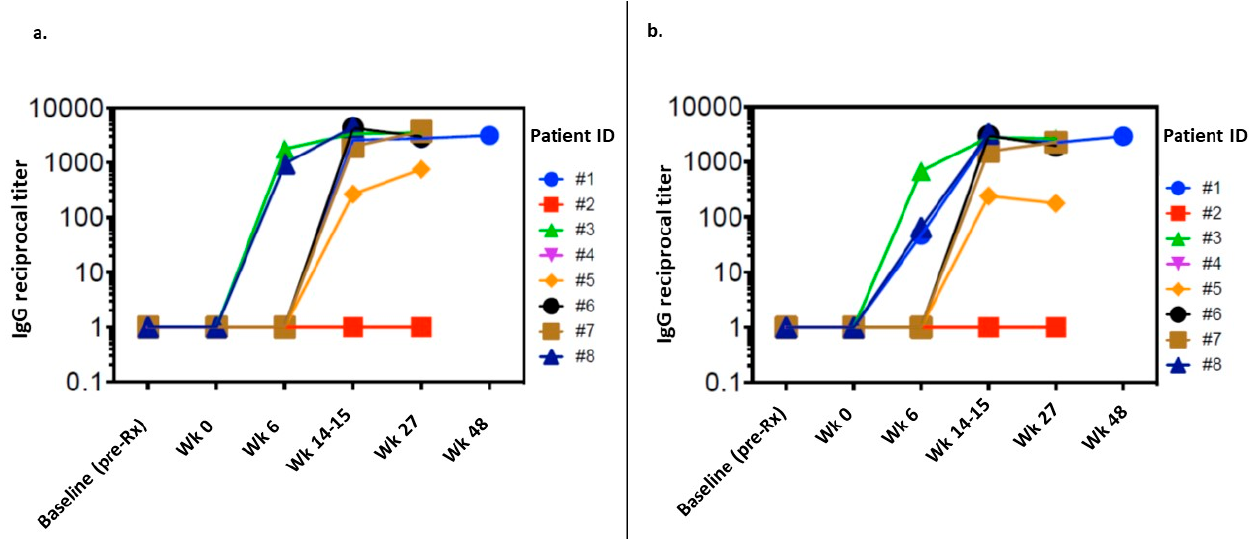
Figure 3. Serum levels of IgG against ( a ) a WT1 peptide pool from the GPS vaccine; ( b ) against the full-length WT1 protein. Ig, immunoglobulin; WT1, Wilms’ Tumor 1; GPS, galinpepimut-S.